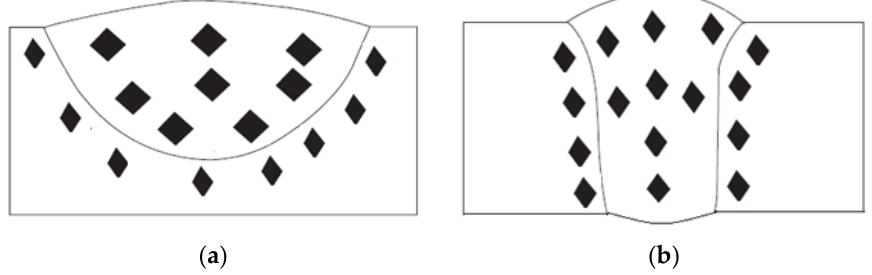
Figure 4. Hardness test locations in the FZ and the HAZ of TIG ( a ) and ATIG ( b ) [13].